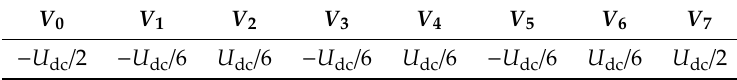
Table 1. Common-mode voltage values of eight basic vectors.